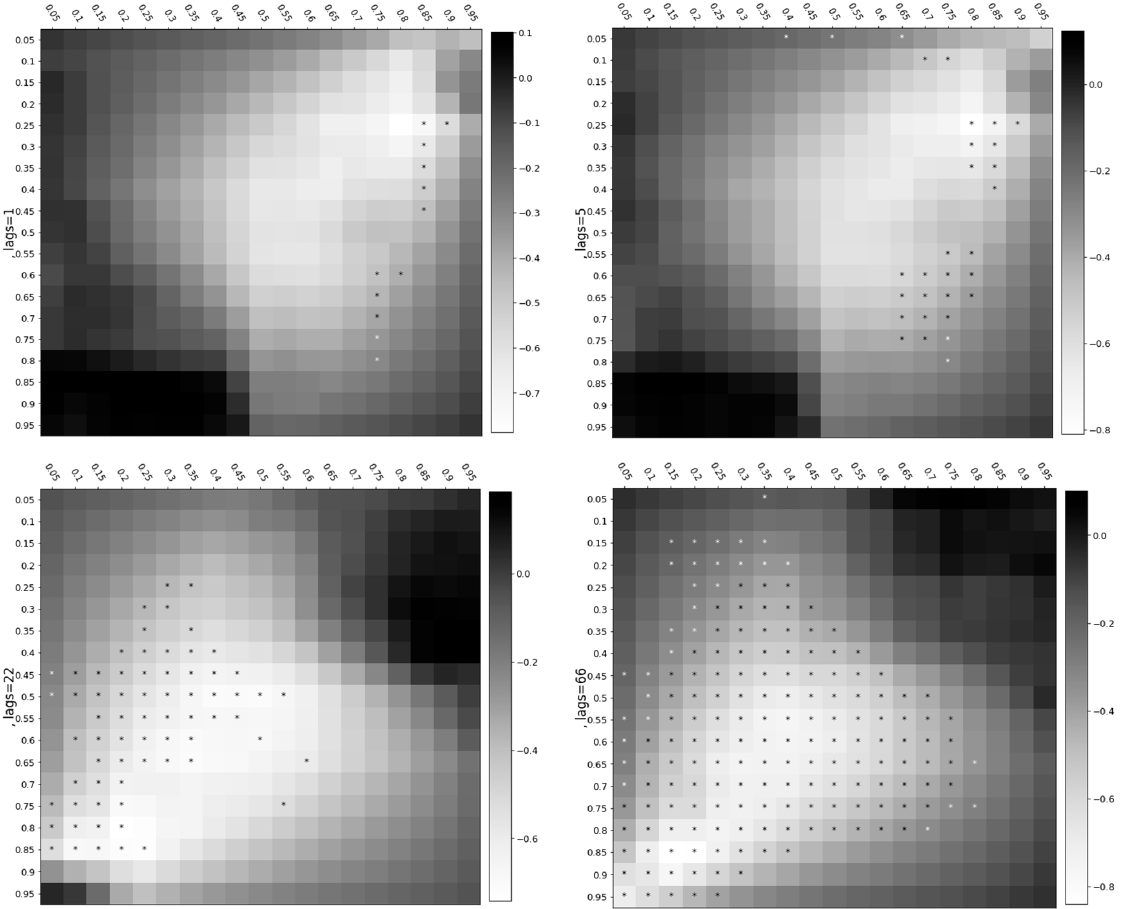
Figure 5. Cross-quantile dependence from AstraZeneca to Sinopharm. Notes: The vertical axis indicates the quantile distribution of AstraZeneca’ stock return, whereas the horizontal axis indicates the quantile distribution of Sinopharm’s stock return. The white-to-black intensity in the bar indicates negative to positive associations.